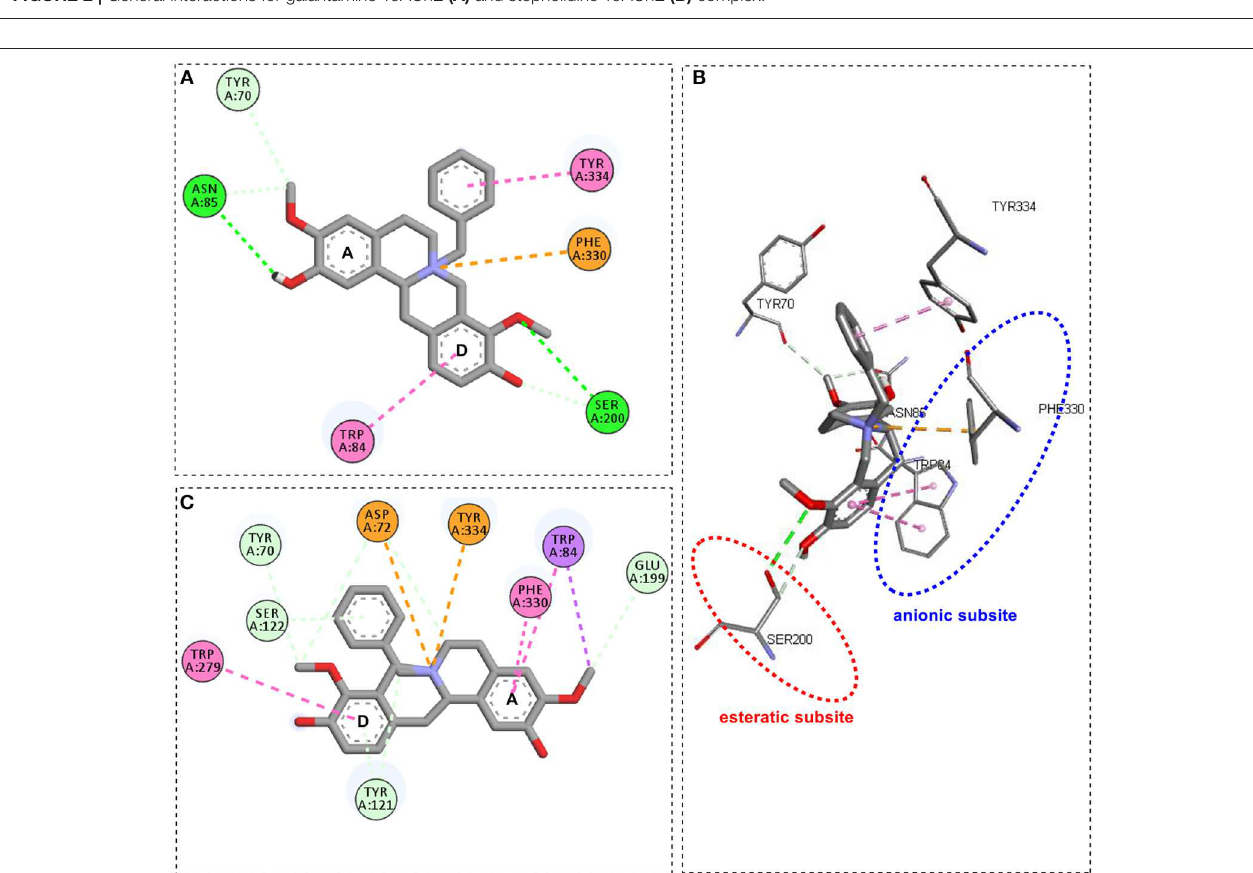
FIGURE 3 | General interactions for compound 1a - Tc AChE complex by 2D diagram (A) and 3D view (B) , and compound 1b - Tc AChE complex by 2D diagram (C) .